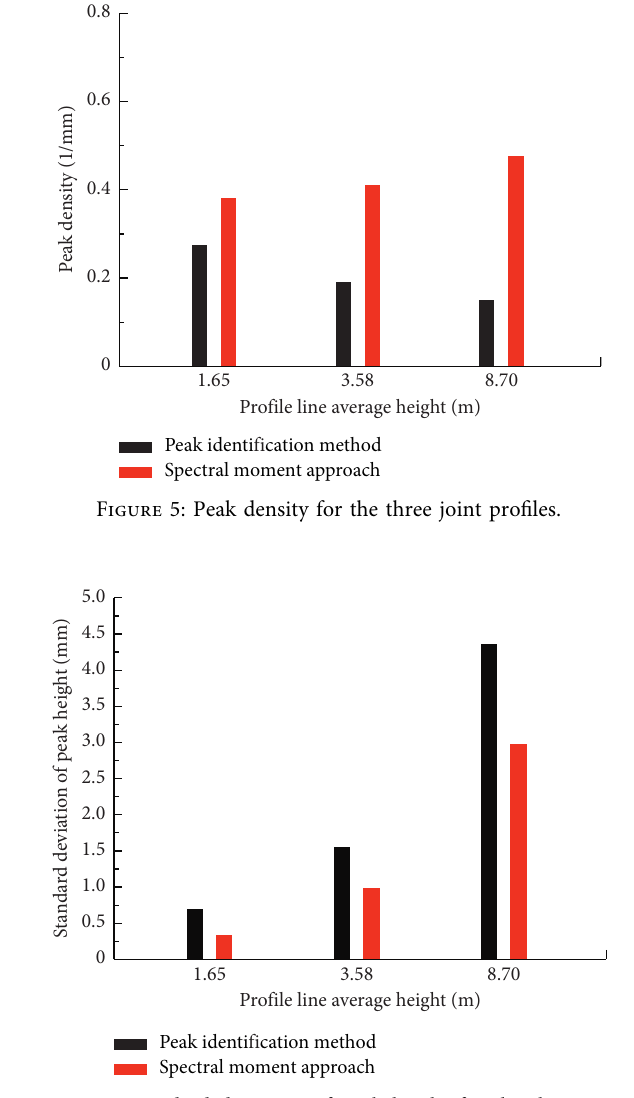
Figure 6: Standard deviation of peak height for the three joint